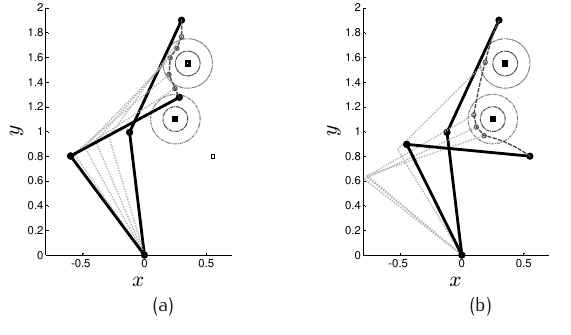
Figure 6. A 2-DOF planar robot moving around 2 obstacles using (a) the APF, and (b) our proposed algorithm.